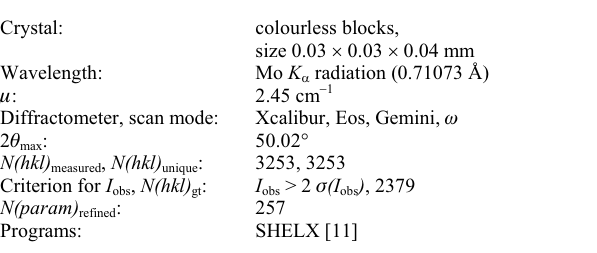
Table 1. Data collection and